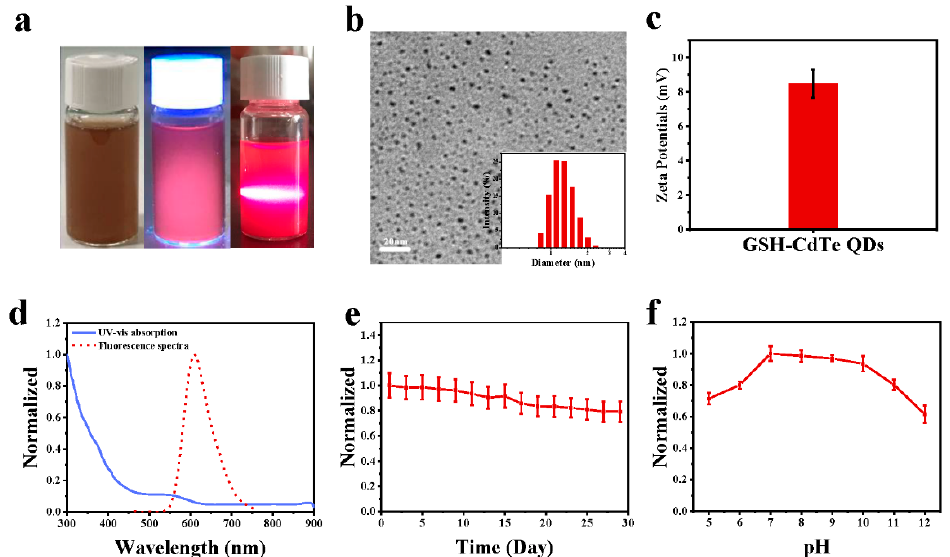
Figure 2. The characterization and stability of GSH-CdTe QDs. ( a ) Photographs of material color, red fluorescence, and Tyndall effect of QDs under natural light, UV, and IR light. ( b ) The TEM image and particle size of GSH-CdTe QDs. ( c ) The zeta potentials of GSH-CdTe QDs. ( d ) The UV-vis absorption and fluorescence spectra of GSH-CdTe QDs. ( e ) The stability of GSH-CdTe QDs via fluorescence spectra under 29 days. ( f ) The pH stability of GSH-CdTe QDs from 5 to 12.